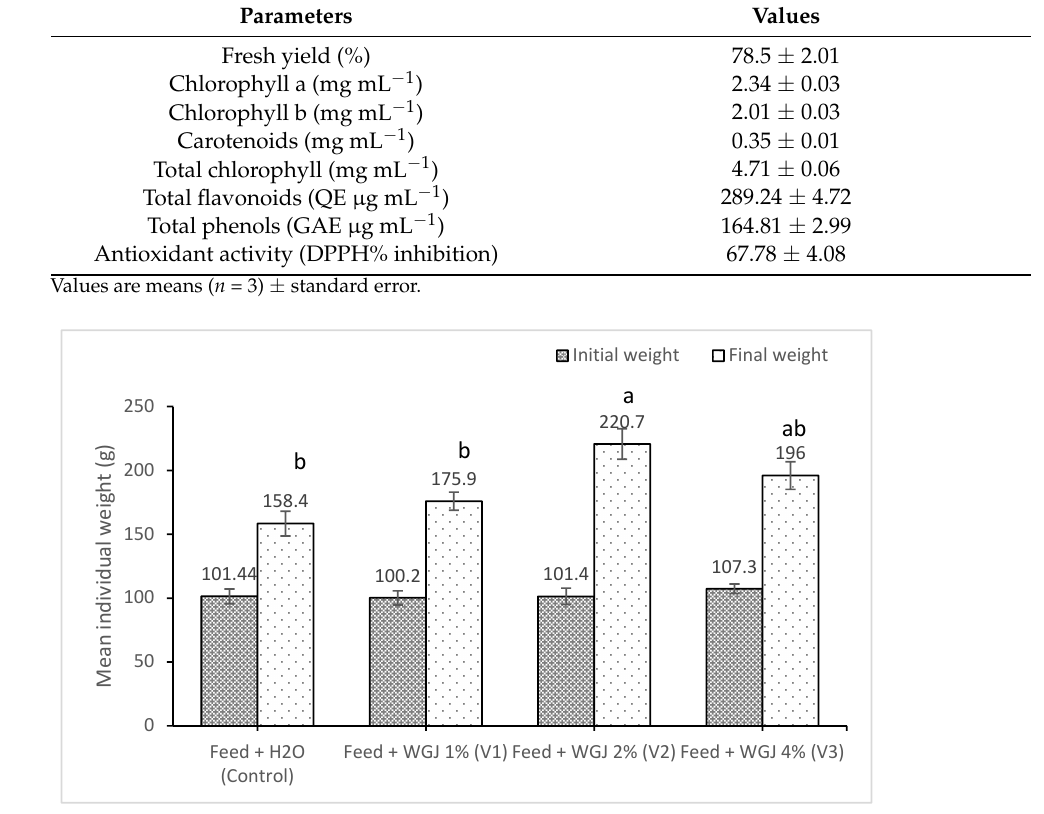
Table 3. Biochemical composition of wheat grass juice.